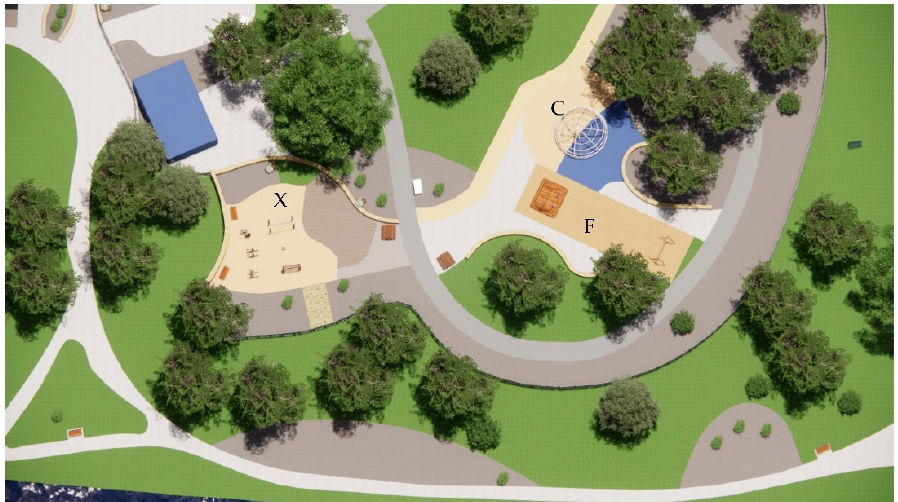
Figure 18. Flying fox, unshaded children’s play areas, and picnic tables during midday on the summer solstice.